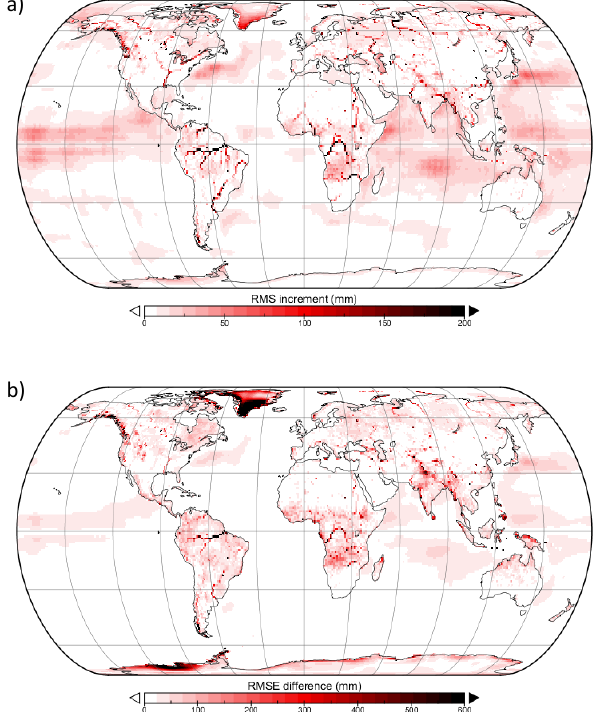
Figure 3. The impact of GRACE data assimilation on total water storage expressed as (a) the root mean square (rms) analysis incre- ment and (b) the rms difference between prior and posterior storage time series.